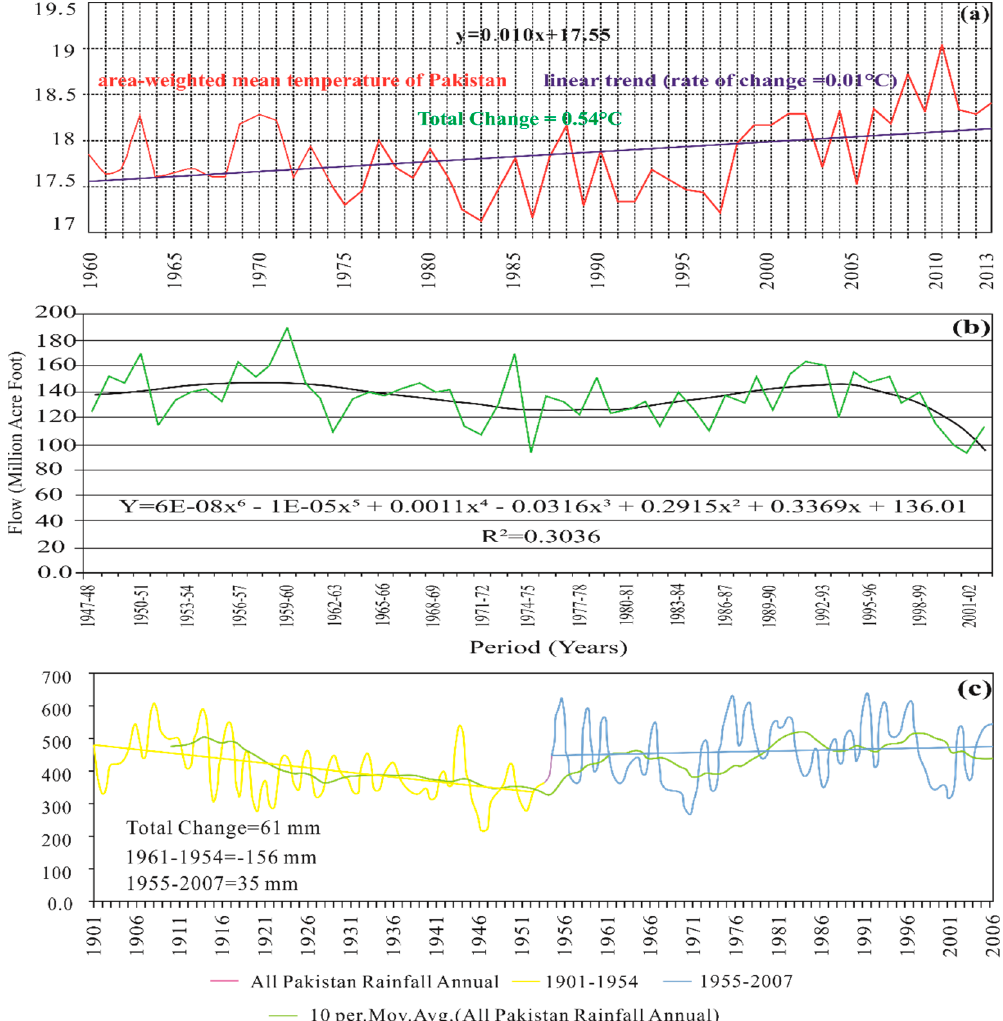
Figure 1. Climate change patterns recorded in Pakistan during the last century: ( a ) area-weighted mean daily temperatures time series. Temperatures are averaged yearly from 1960 to 2013 (modified from [9,13]). ( b ) Annual average precipitation time series (modified from [10]). ( c ) Annual river flows of the Indus River System in Pakistan, from 1947 to 2002 (modified from [9]).